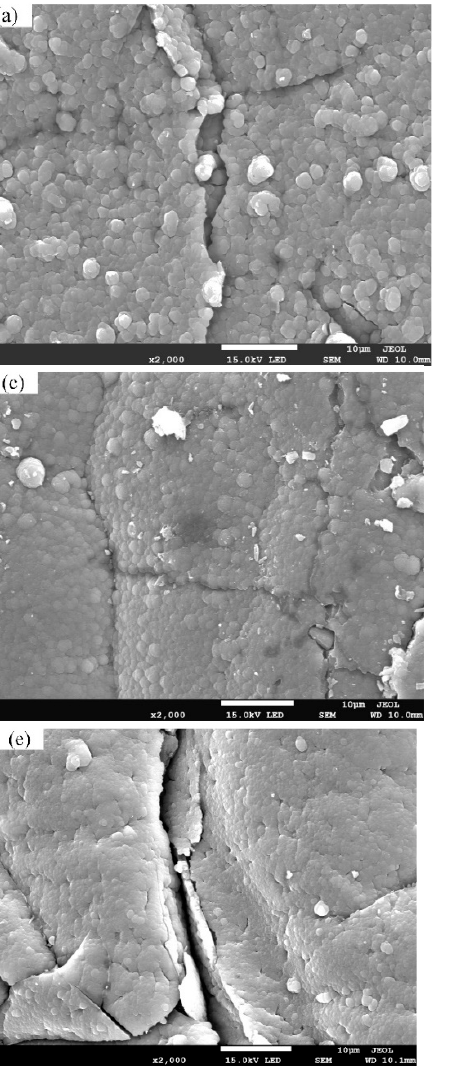
Figure 3. SEM images of surface morphology and micro-defects of (Ti:N)-GLC films: ( a ) surface morphology of Ti-C (100); ( b ) surface morphology of TiC-C (100); ( c ) surface morphology of TiN-C (100); ( d ) micro-defects of Ti-C (200) show cracks; ( e ) micro-defects of TiC-C (200) show sharp cracks; ( f ) mico-defects of TiN-C (200) show cracks and debris. Table 1. Chemical composition of (Ti:N)-GLC